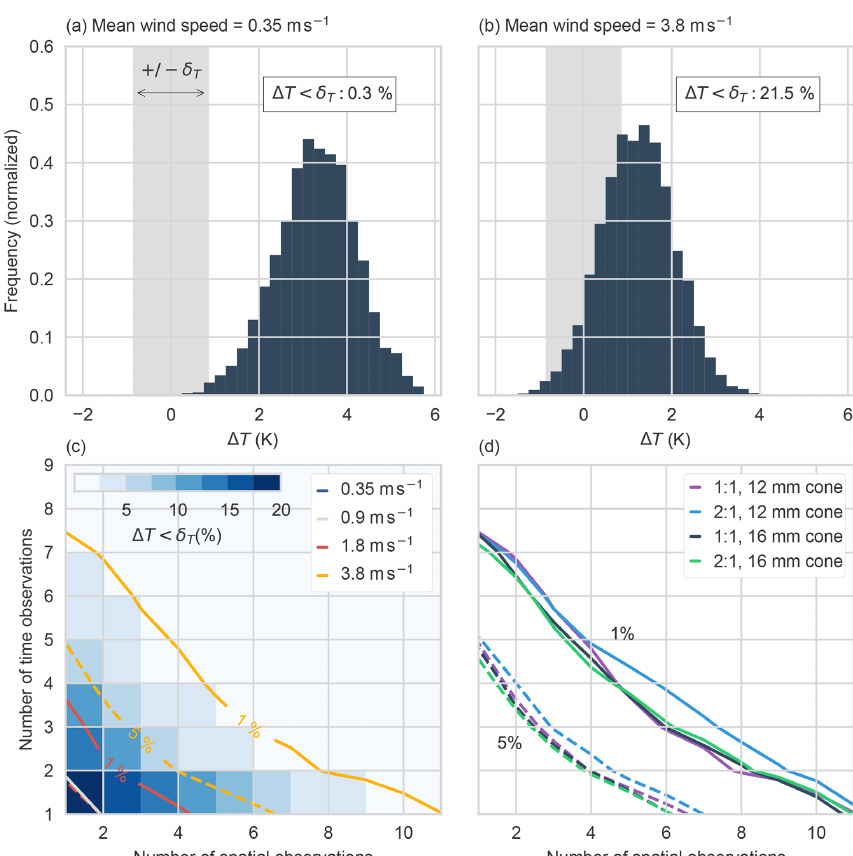
Figure 4. The distribution of temperature differences between cables with opposing cone orientations for the 16mm, 1 : 1 cones with 2cm spacing and a heating rate of 2.5Wm − 1 for (a) a wind speed of 0.35ms − 1 and (b) a wind speed of 3.8ms − 1 . The grey region indicates the uncertainty, δ T . The percentage of observations with (cid:49)T < δ T is indicated. (c) A 2-D histogram of the percentage of (cid:49)T < δ T as a function of averaging interval in time and space for the highest wind speed (same data as in b ). The contours for the 1% and 5% thresholds are indicated for each wind speed. Note that the 0.35ms − 1 wind speed is always below the 1% threshold. (d) The 1% and 5% contours for the acceptable cone aspect ratios and sizes at the highest wind